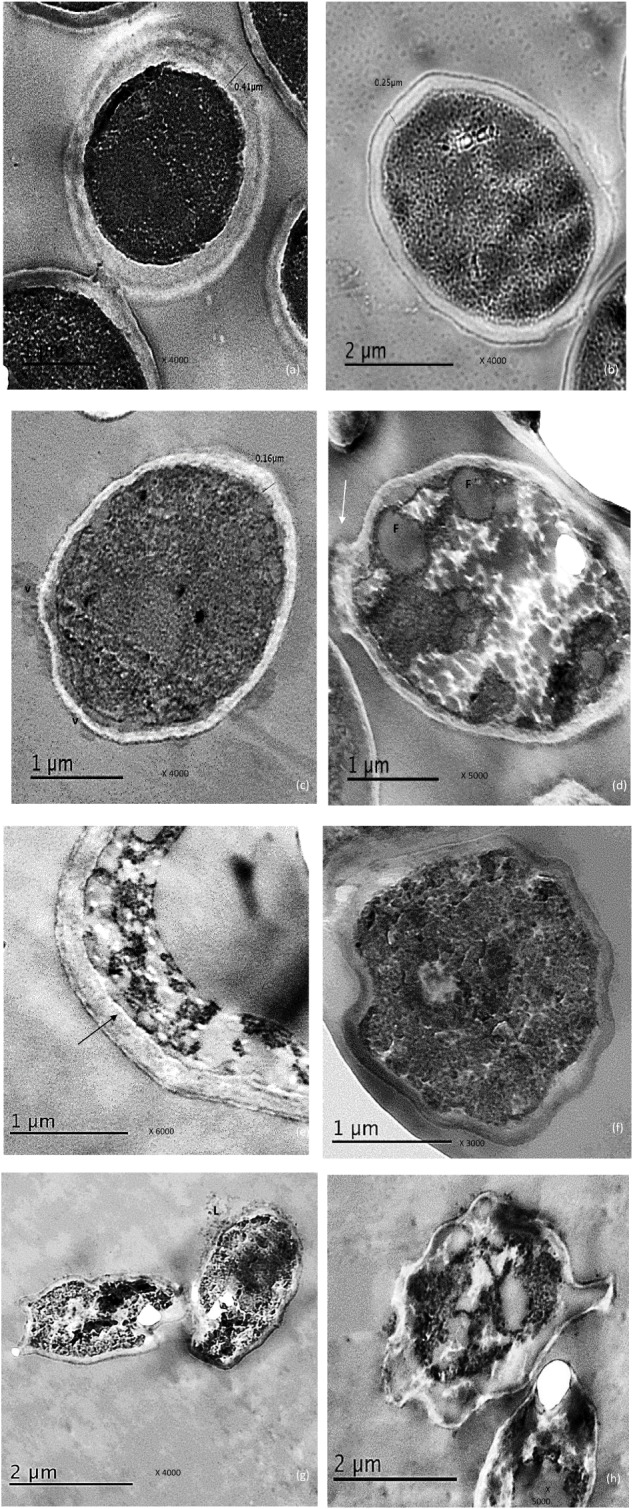
Electro micrographs of C. albicans cells examined by TEM showing, (a) the control cells with thick, intact cell and dense cytoplasm, (b) reduced cell wall thickness in urea –treated cells, (c) Thin cell wall as well membrane–limited vesicles (V) representing remnants of destroyed cells when exposed to miconazole, (d) some fat deposits (F), damage in the cell wall (arrow) and disrupted cytoplasm were observed in miconazole treated cells, (e) disruption in the contact between the cell wall and the inner membrane in miconazole treated cells (arrow), (f) early apoptotic cell with condensed chromatin for urea/miconazole treated cells, (g) leakage (L) was clearly detected in combination exposed cells (arrow), (h) necrotic cells with damaged cytoplasm in combination treated cells. The magnification power was written on each photo.